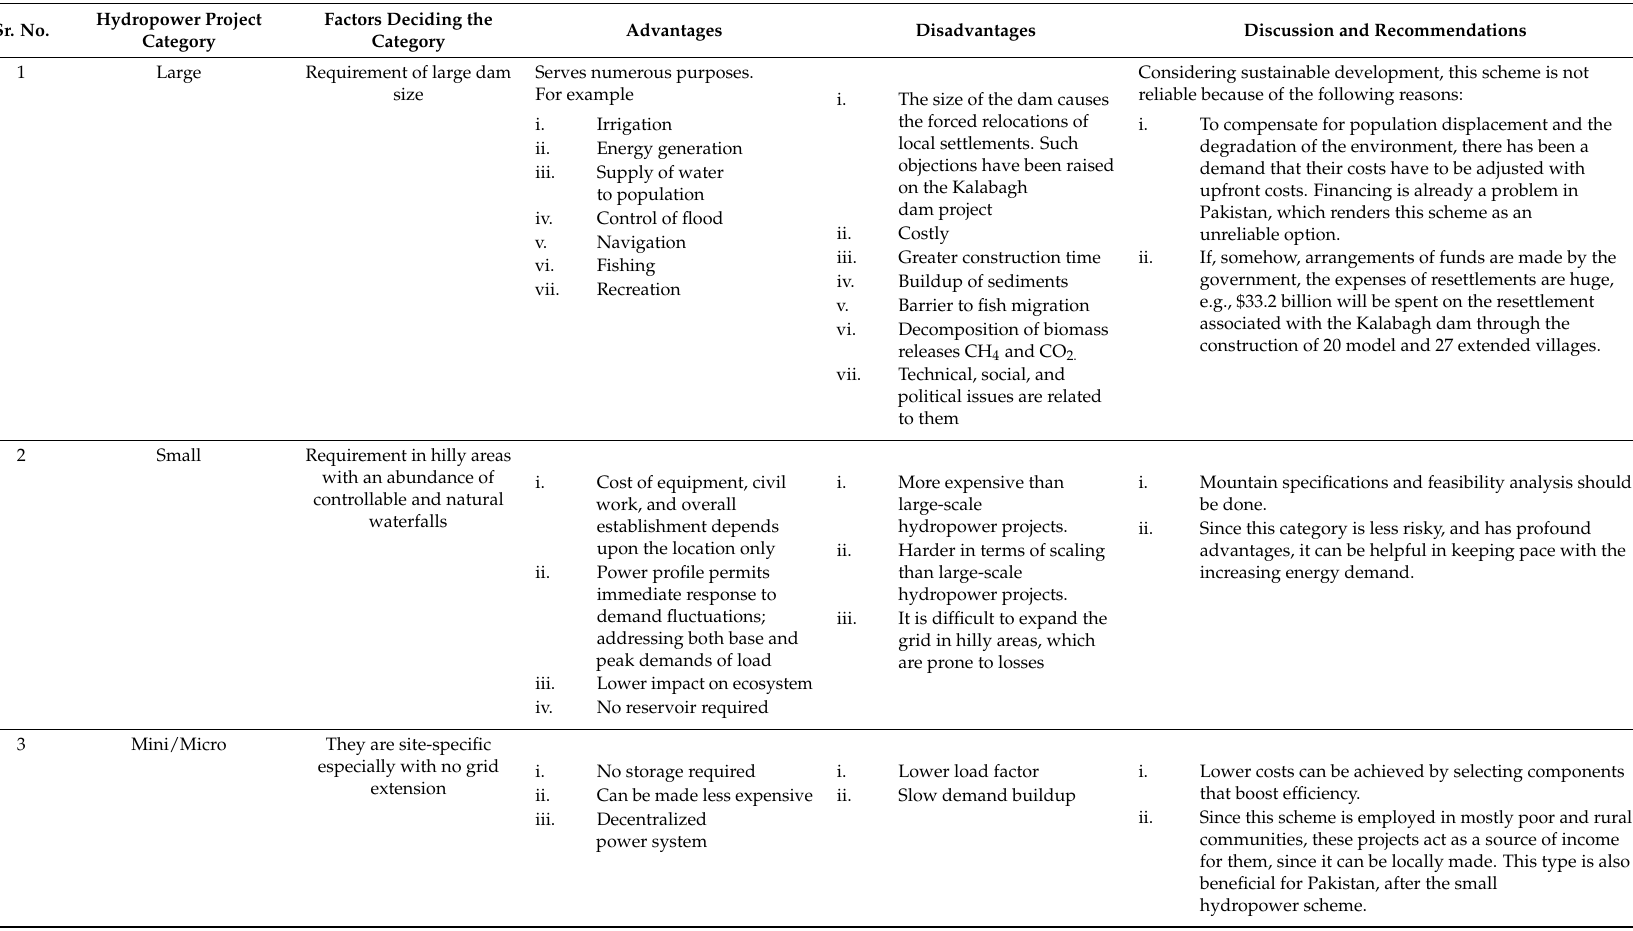
Table 26. Analysis of hydropower potential in Pakistan’s